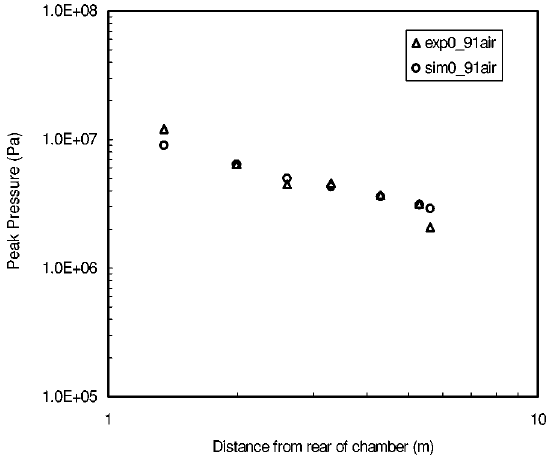
Fig. 4. Comparison between experiment and computation for 0.91 kg C4 charge detonation in air.